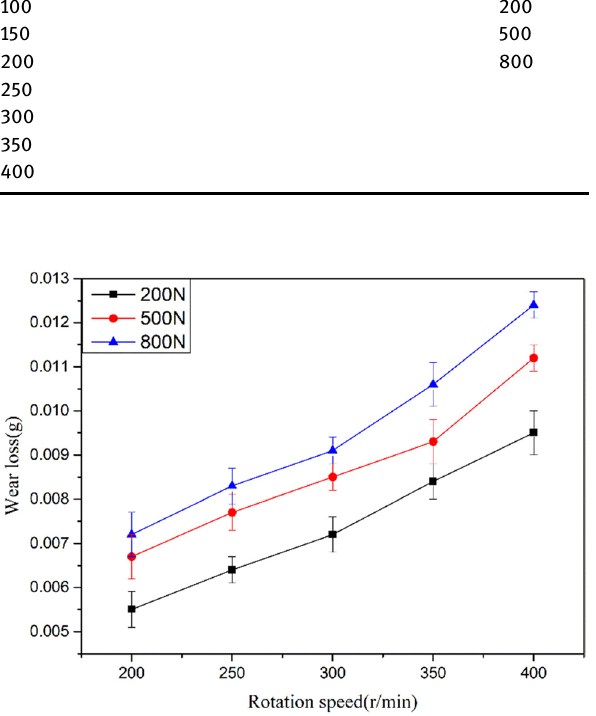
Figure 6: E ff ect of rotation speed on material wear.